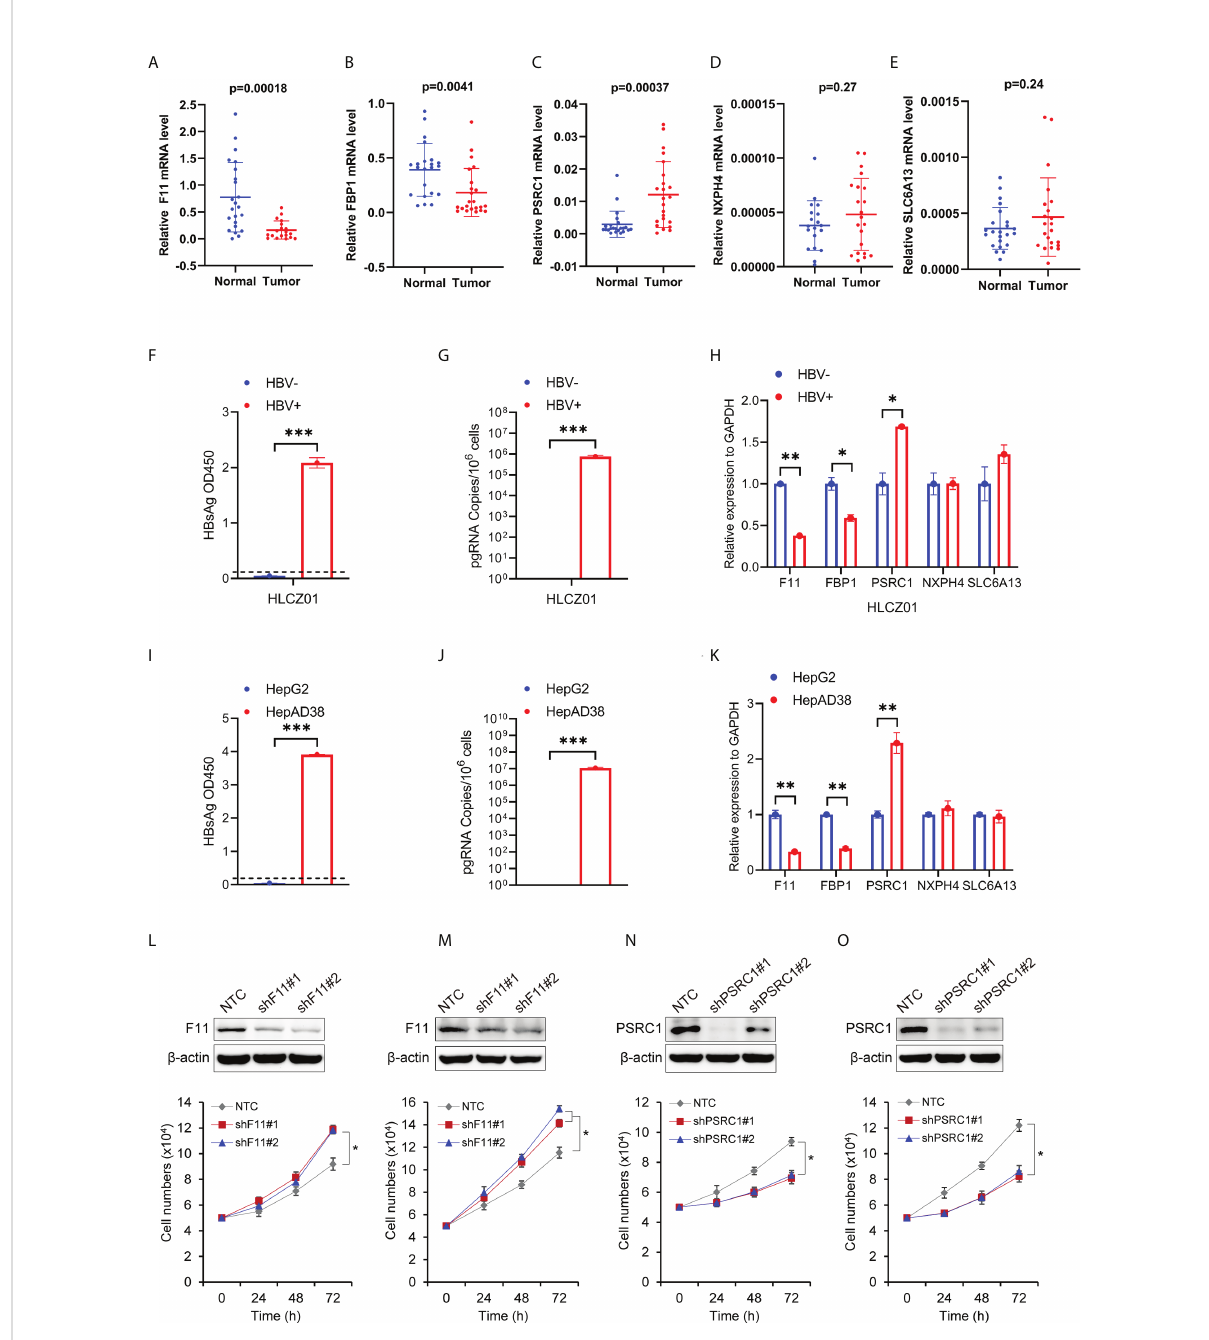
FIGURE 9 The expression levels of the fi ve RBP-related mRNAs in HCC tissues and cells, and their effect on cell proliferation. The scatter plots show F11 (A) , FBP1 (B) , PSRC1 (C) , NXPH4 (D) , and SLC6A13 (E) mRNA expression levels in HCC tissues (Tumor) and adjacent normal tissues (Normal). (F) HBsAg in the supernatant of HBV-infected (HBV+) or uninfected (HBV-) HLCZ01 cells was detected by ELISA. (G) The viral pregenomic RNA level determined by real-time PCR was shown as the number of HBV pregenomic RNA copies per 10 6 cells. (H) The mRNA abundance of F11, FBP1, SLC6A13, NXPH4, and PSRC1 was assayed in HBV+ or HBV- HLCZ01 cells. The differences of HBsAg, the viral pregenomic RNA level, and the fi ve RBP-related mRNAs ’ expression levels were also compared between HepG2 (HBV-) and HepAD38 (HBV+) cell lines (I – K) . The expression levels of the fi ve RBP-related mRNAs were normalized by GAPDH mRNA. Cell growth was determined by trypan blue counting in Hep3B (L) or PLC (M) cells expressing NTC or shF11 (shF11#1 or shF11#2). Knockdown ef fi ciency of F11 was veri fi ed by Western blotting. Cell growth was also determined by trypan blue counting in Hep3B (N) or PLC (O) cells expressing NTC or shPSRC1 (shPSRC1#1 or shPSRC1#2). Knockdown ef fi ciency of PSRC1 was veri fi ed by Western blotting. *P<0.05 between the indicated groups; **P<0.01 between the indicated groups; ***P<0.001 between the indicated